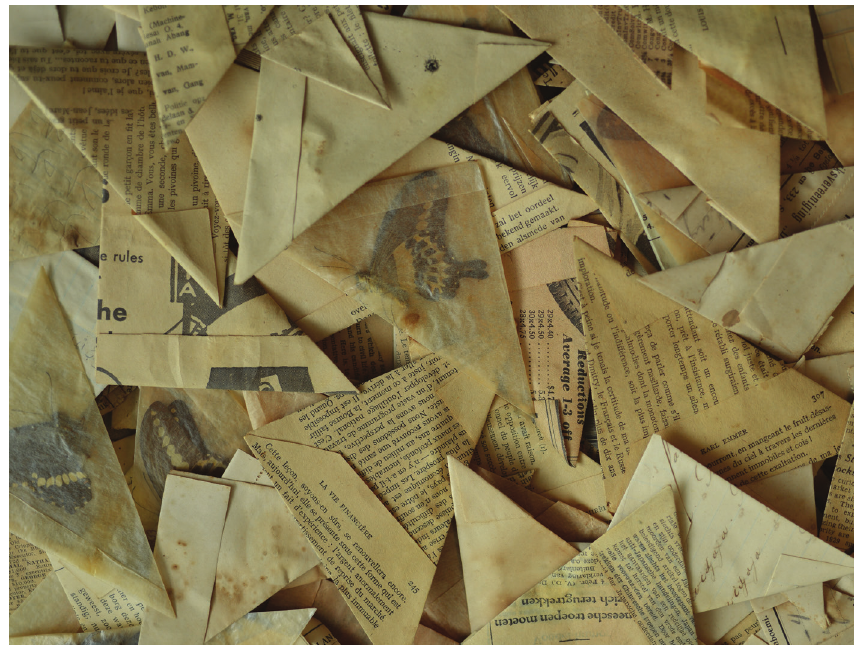
Figure 1. Overview of the contents of a drawer with papered